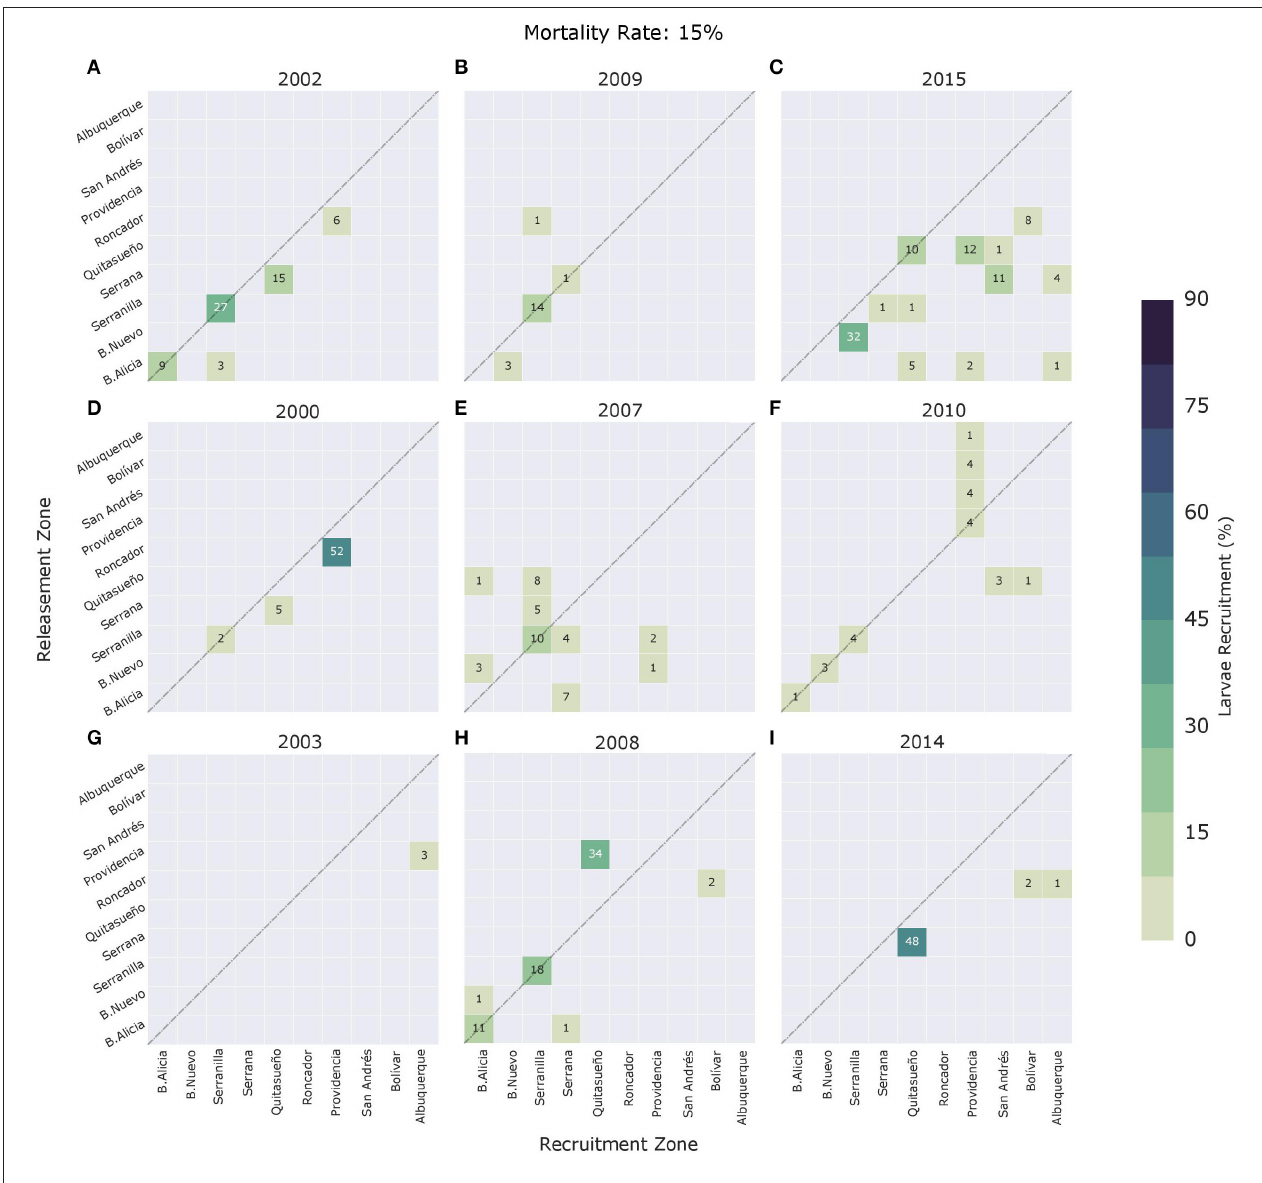
FIGURE 10 | Connectivity matrices for the (A) 2002, (B) 2009, (C) 2015, (D) 2000, (E) 2007, (F) 2010, (G) 2003, (H) 2008, and (I) 2014 spawning events, using a daily mortality rate of 15%. Upper panels correspond to El Niño years, middle panels to La Niña years, and bottom panels to neutral ENSO condition years. Connectivity matrix shows the strength of each connection based on the amount received by reef j (x-axis) and contributed by reef i (y-axis). The diagonal of the matrix indicates reefs where local retention